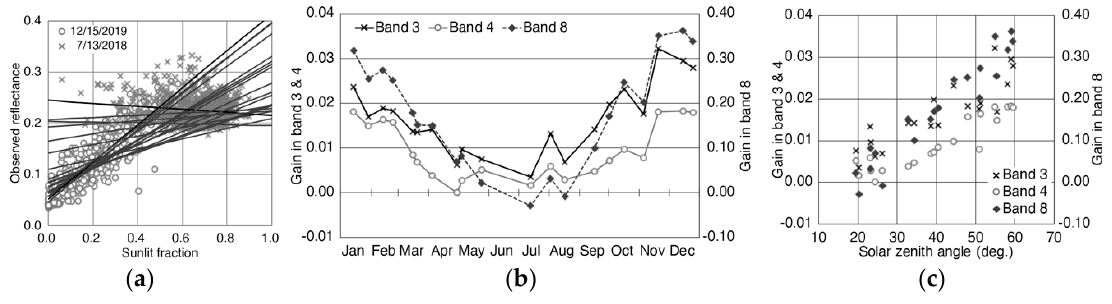
Figure 9. ( a ) All regression lines of scene-based correction in the near-infrared (NIR, band 8), together with scatter plots in summer and winter. ( b ) Seasonal change in the gain in the linear regression. ( c ) Scatterplot of the gain in the linear regression in relation to the solar zenith angle.